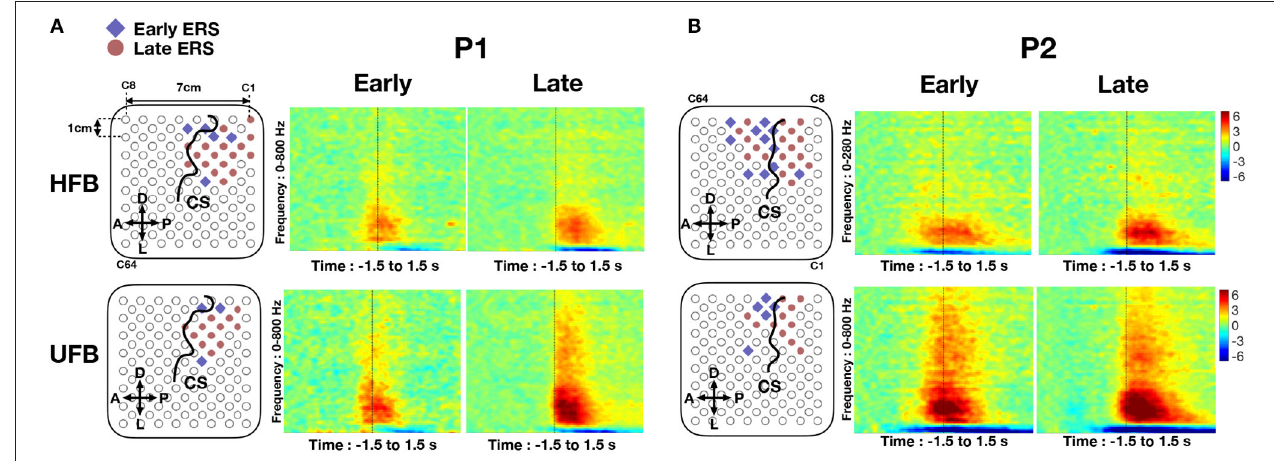
FIGURE 9 | (A) The early-ERS (blue diamond) and late-ERS (red circle) channel distributions on the grid and average time-frequency maps in HFB (top) and UFB (bottom) frequency range for P1. (B) Same analysis results for P2. Non significant channels were left as blank in the grid map. Central sulcus (CS) was denoted by a black curve. Orientations were denoted by “A” (anterior), “P” (posterior), “D” (dorsal) and “L” (lateral). The average time-frequency maps were visualized in a frequency range of 0–800 Hz and covered a period of − 1.5 s to 1.5 s. All time-frequency maps were displayed in − 6 to 6 dB.